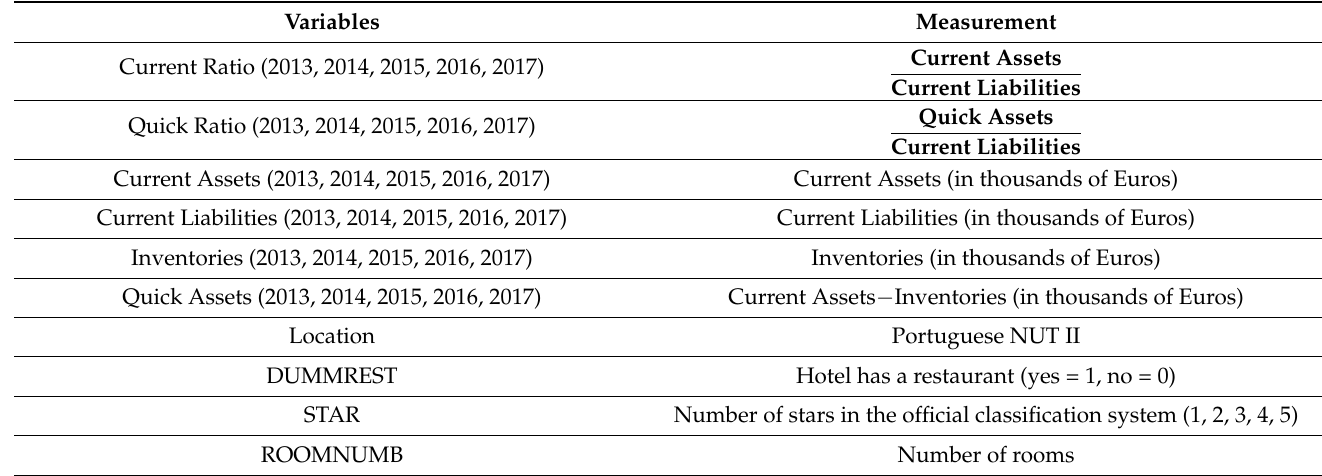
Table 4. Measurement of